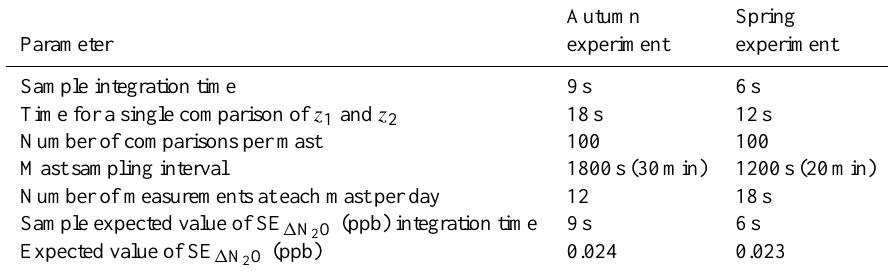
Table 1. Valve timings of the GVA and mast manifold and associated precision of the 1 N 2 O measurement.